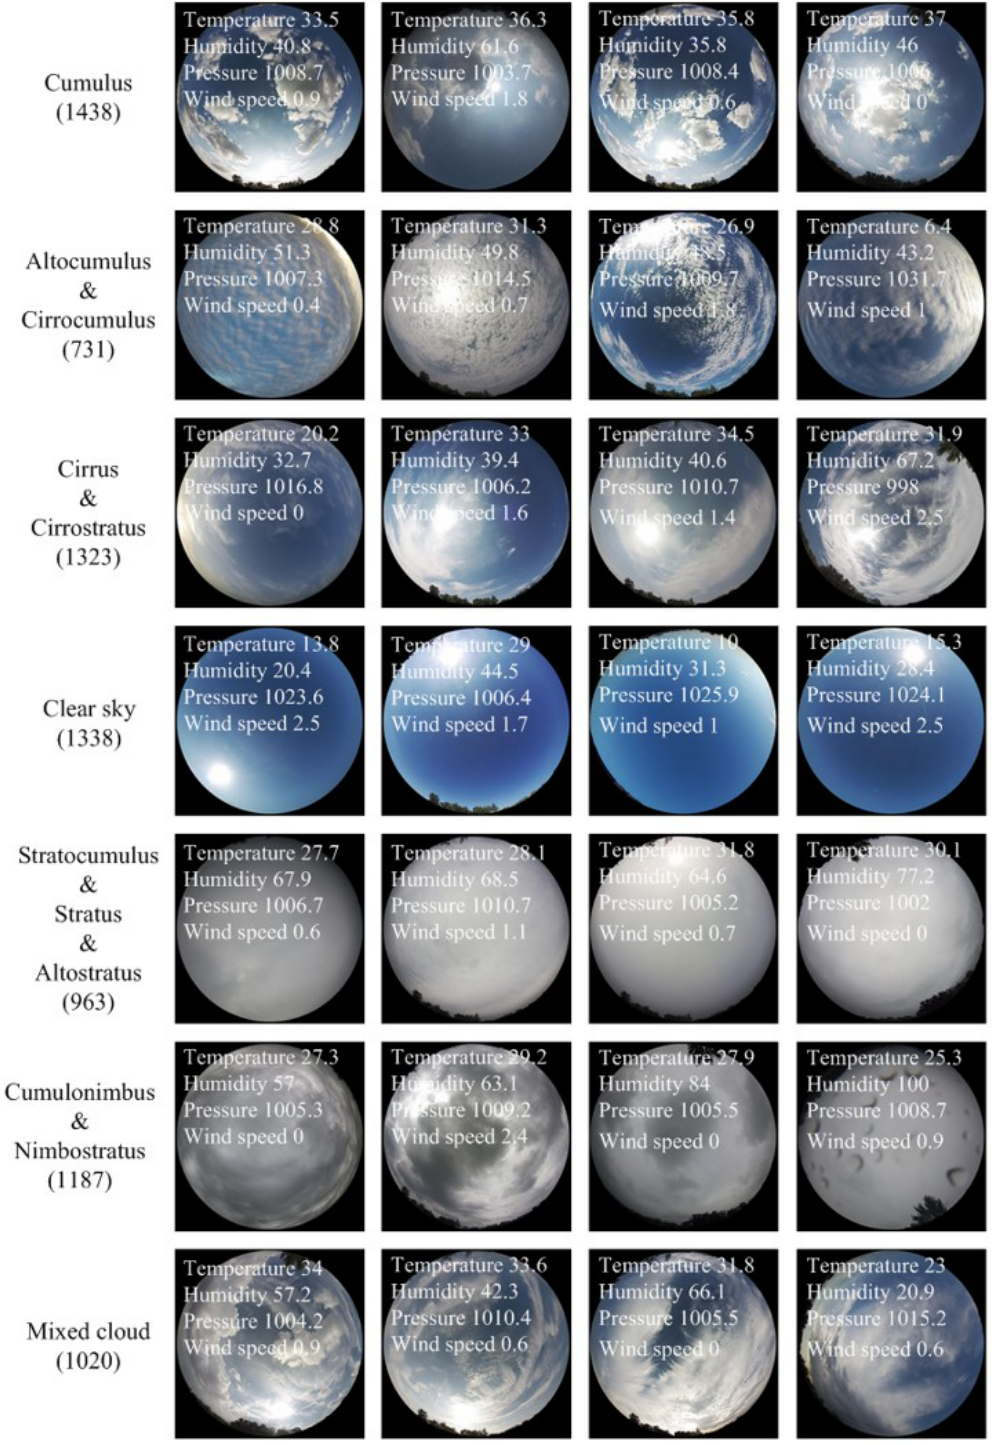
Figure 7. Some samples from each category in multi-modal ground-based cloud dataset (MGCD), where the multi-modal information is embedded in the corresponding ground-based cloud